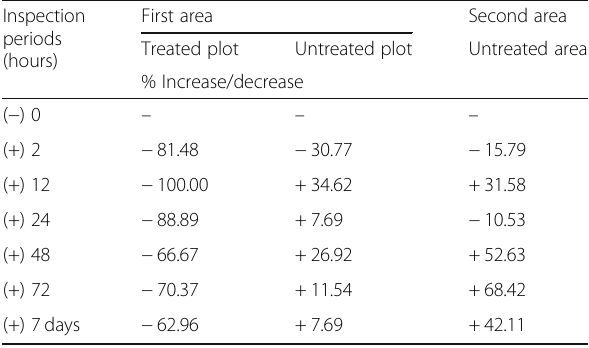
Table 2 Percentage of increase or decrease in population densities of Coccinella undecimpunctata adults in untreated and sulfur-treated marrow cultivations